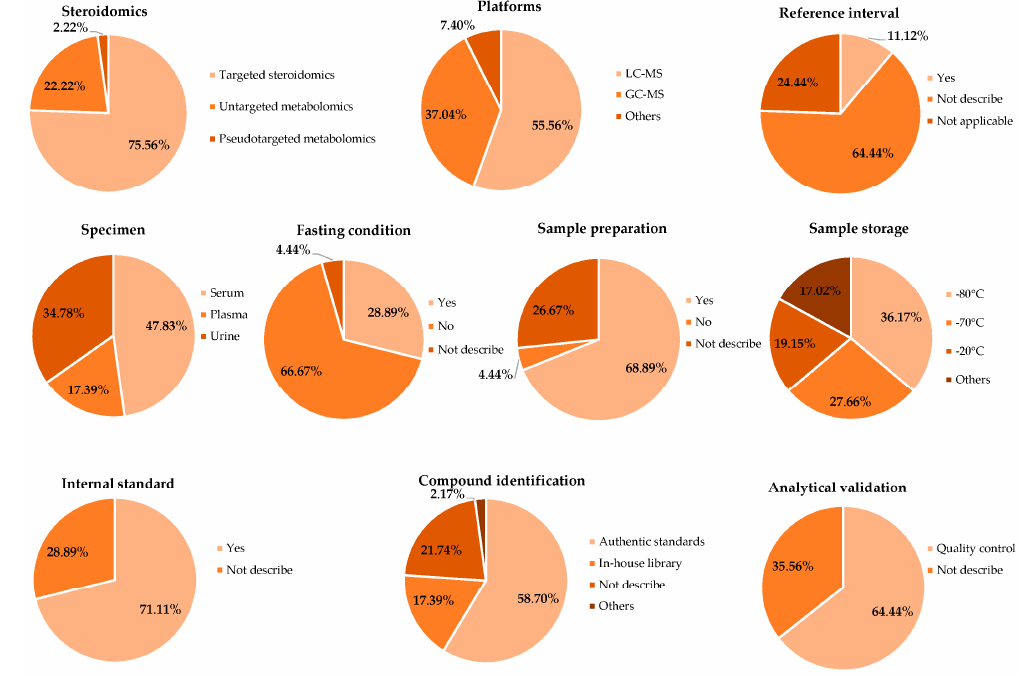
Figure 2. Study design and metabolomics approach of the included studies.